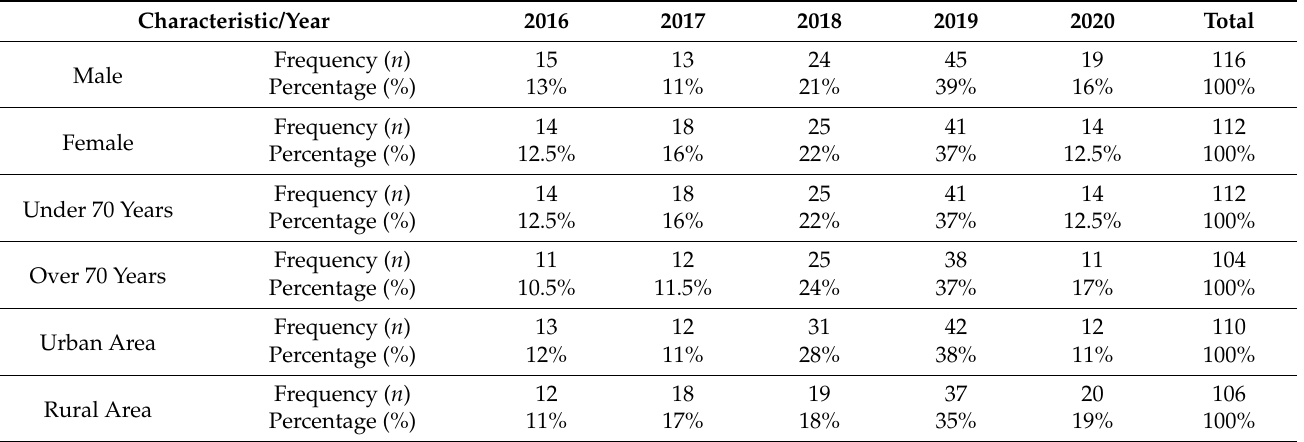
Table 1. Distribution of subjects according to the year of diagnosis, gender, age group, and the environment of origin.